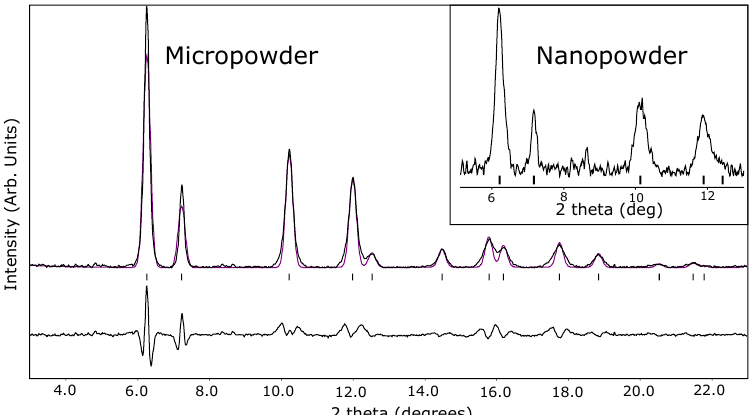
Figure 2. Powder X-ray diffraction pattern of cerium dioxide micropowder at 17.9 GPa collected using 0.3344Å radiation. Integrated data in black with LeBail fit in red and residual below. Tics show angles of allowed reflections of low-pressure Fm ¯3 m phase. Inset: Integrated pattern from nanopowder at 12.0 GPa, the peaks are broadened due to size effects. Additional diffraction patterns are shown in the supplemental